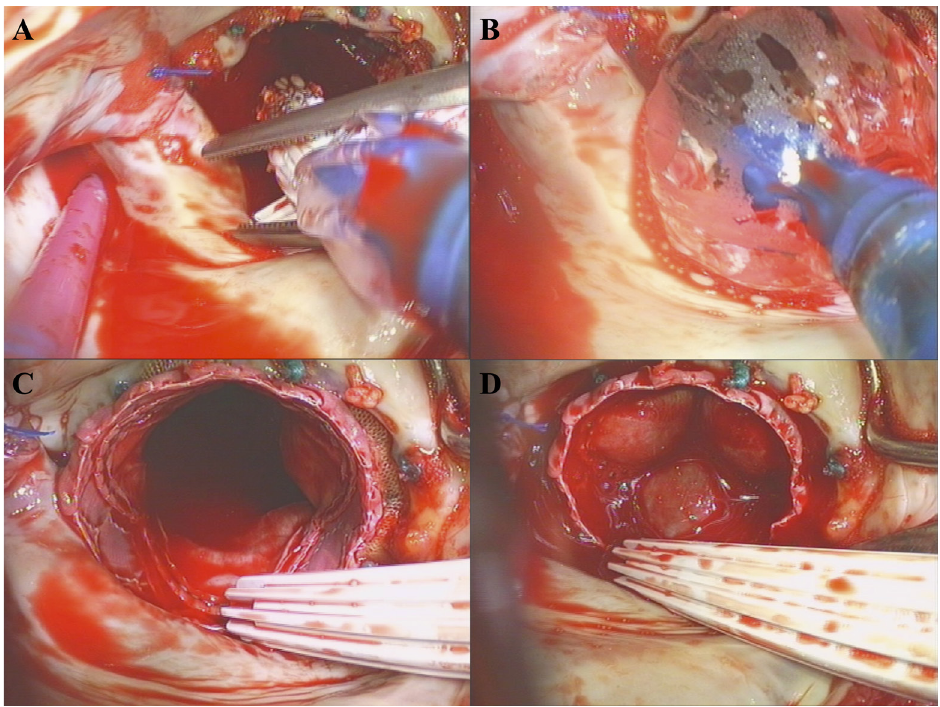
Fig. 2 - Open transcatheter valve implantation. A) positioning of the TAVI system in the mitral valve annulus; B) balloon dilatation of the TAVI prosthesis; C) TAVI prosthesis in mitral position, left atrial view; D) competent TAVI prosthesis in mitral position, left atrial